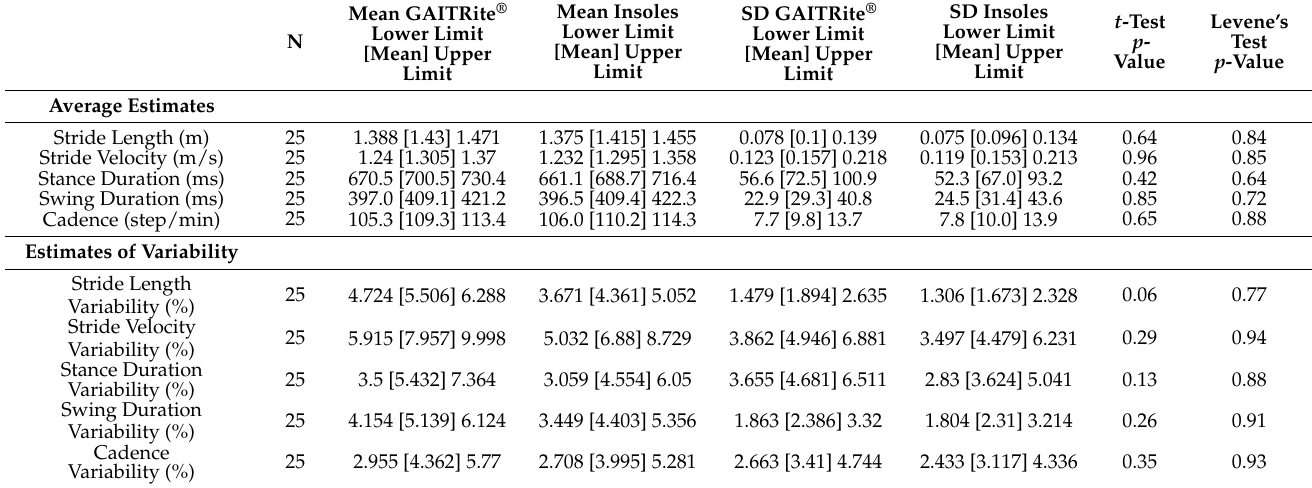
Table 2. Values of average estimates and estimates of variability for the unipedal gait parameters with the following statistics: sample size (N), mean and standard deviations (SD) with GAITRite ® , mean and standard deviations (SD) with insoles and p-values of t -test with independent samples and Levene’s test between GAITRite ® and the insoles.